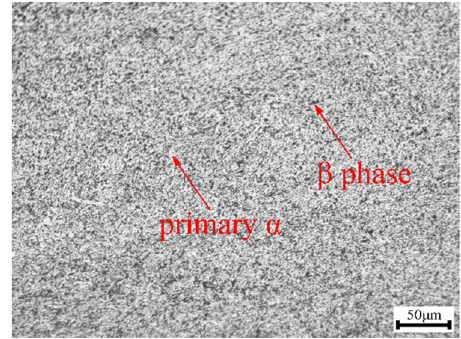
Figure 1: Microstructure of TA15 titanium alloy.